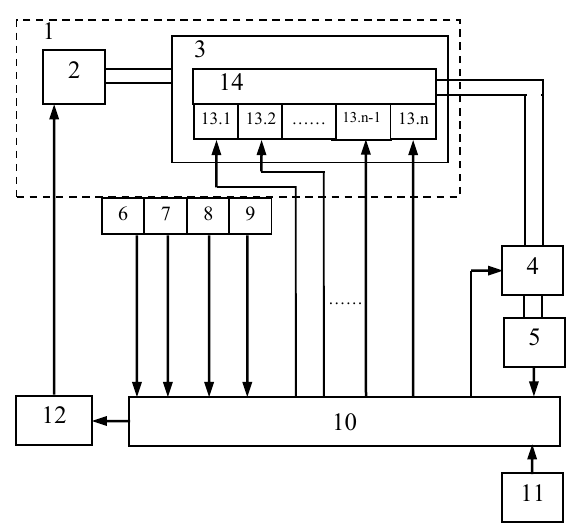
Figure 2. Structural diagram of the electric controller with the possibility to control the moment of the fuel supply start: (1) DGS; (2) generator; (3) diesel engine; (4) actuator; (5) sensor for moving the racks of mechanical HPFP; (6) sensor of a crankshaft speed; (7) diesel temperature sensor; (8) sensor of pressure of air pressurization; (9) TDC (10) microcontroller control unit; (11) device for setting the diesel engine shaft speed; (12) generator load power control unit; (13) regulating solenoid valves (SV) 13.1 ÷ 13.n (n – number of cylinders of the diesel engine 3); (14) HPFP The control system works as follows. The parameter that determines the load power of diesel engine 3 and, accordingly, of diesel generator set 1, is the amount of fuel that enters diesel engine 3 through HPFP 14 equipped with 13.1 ÷ 13.n regulating SV and the control rack of mechanism 4. The amount of fuel depends both on